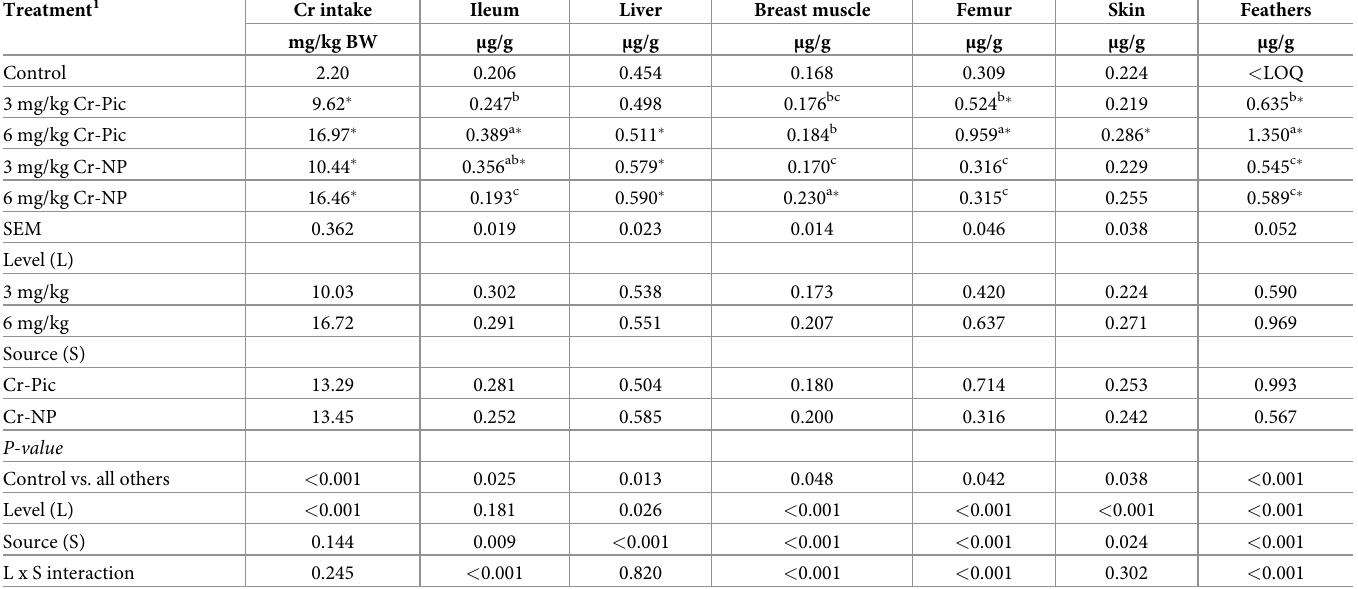
Table 2. Cr content in selected tissues and